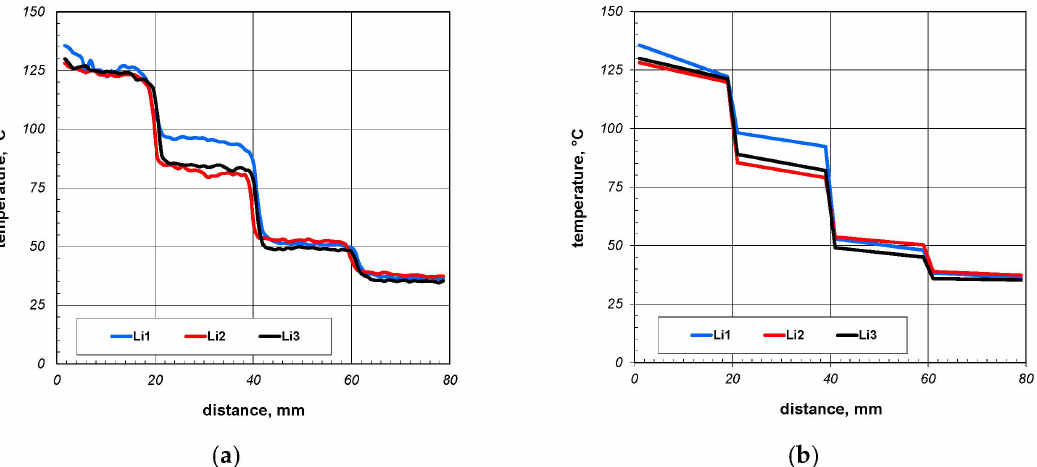
Figure 21. ( a ) Changes in temperature along the line Li1–Li3 from the thermogram 20b; ( b ) tempera- ture changes along the Li1–Li3 line after